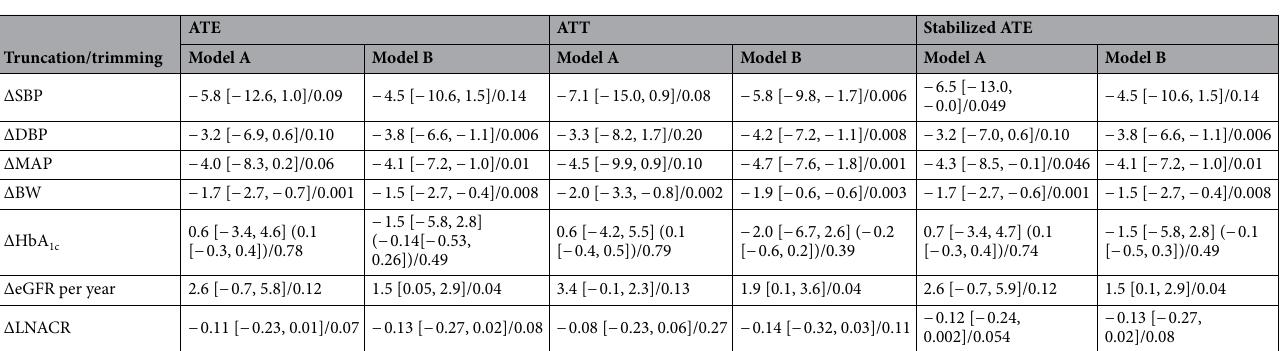
Figure 1. The integrated OR using six models by meta-analysis method. *Calculated number of participants after weighting. ATE average treatment effect, ATT average treatment effect on the treated, BP blood pressure, CI